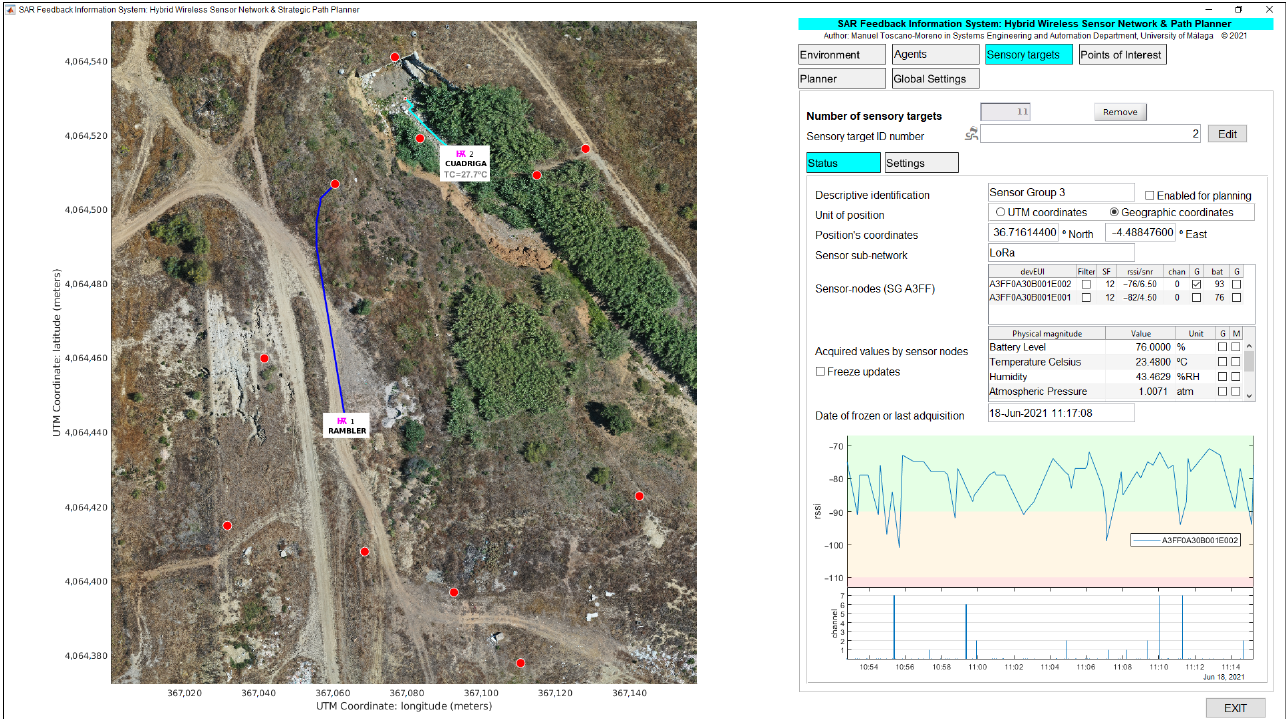
Figure 5. SAR-FIS displaying sensory information from a sensory target with path-planning for UGVs Cuadriga and